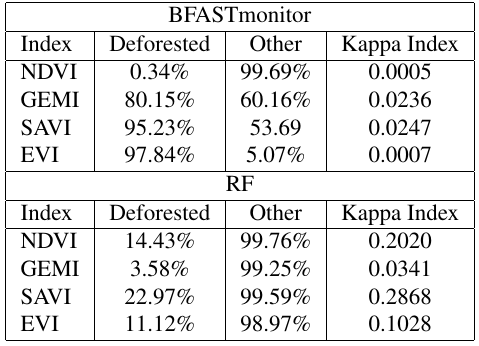
Table 1. Correctness assessment of pixel